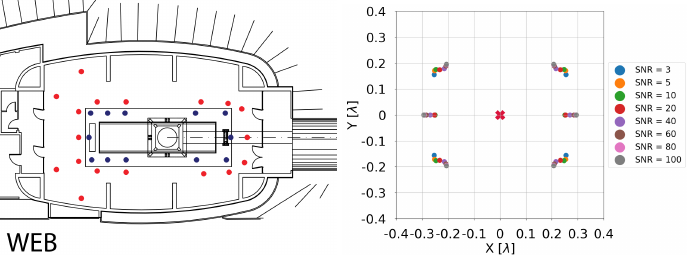
Figure 13. Comparison between the optimal array obtained for the West End Building (WEB) in Virgo ( left ) and the optimal array obtained for an isotropic and homogeneous Rayleigh wave field ( right ). The blue dots in the left figure represent sensors placed on the tower platform (which is anchored to the bedrock with pillars), whereas the red dots represent sensors placed on the floor of the building. The optimal array in the right figure is represented with different values of SNR. The right figure was taken from [62].